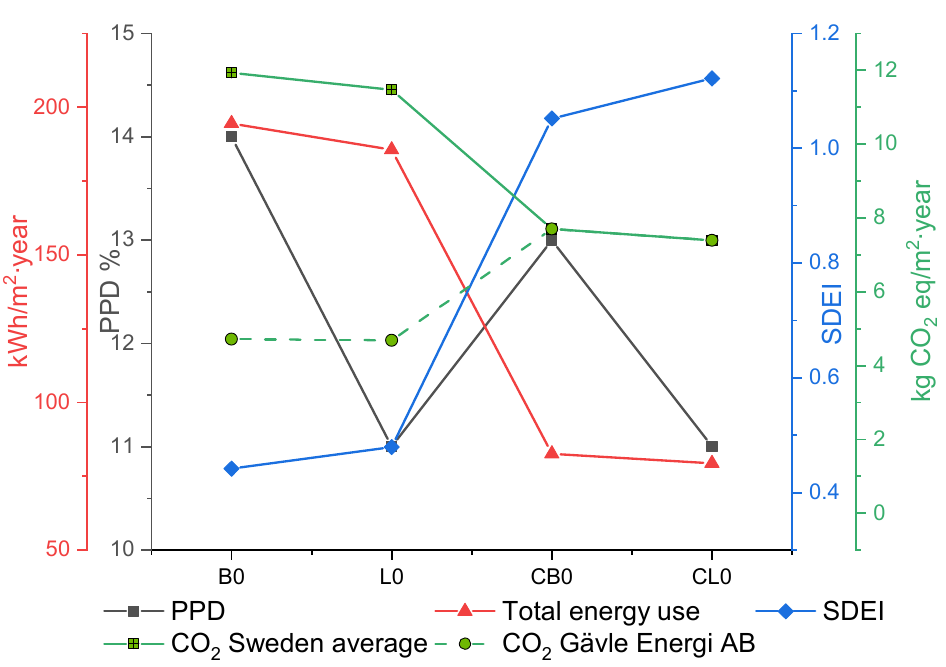
Figure 22. Collective results for B0, L0, and C-cases.